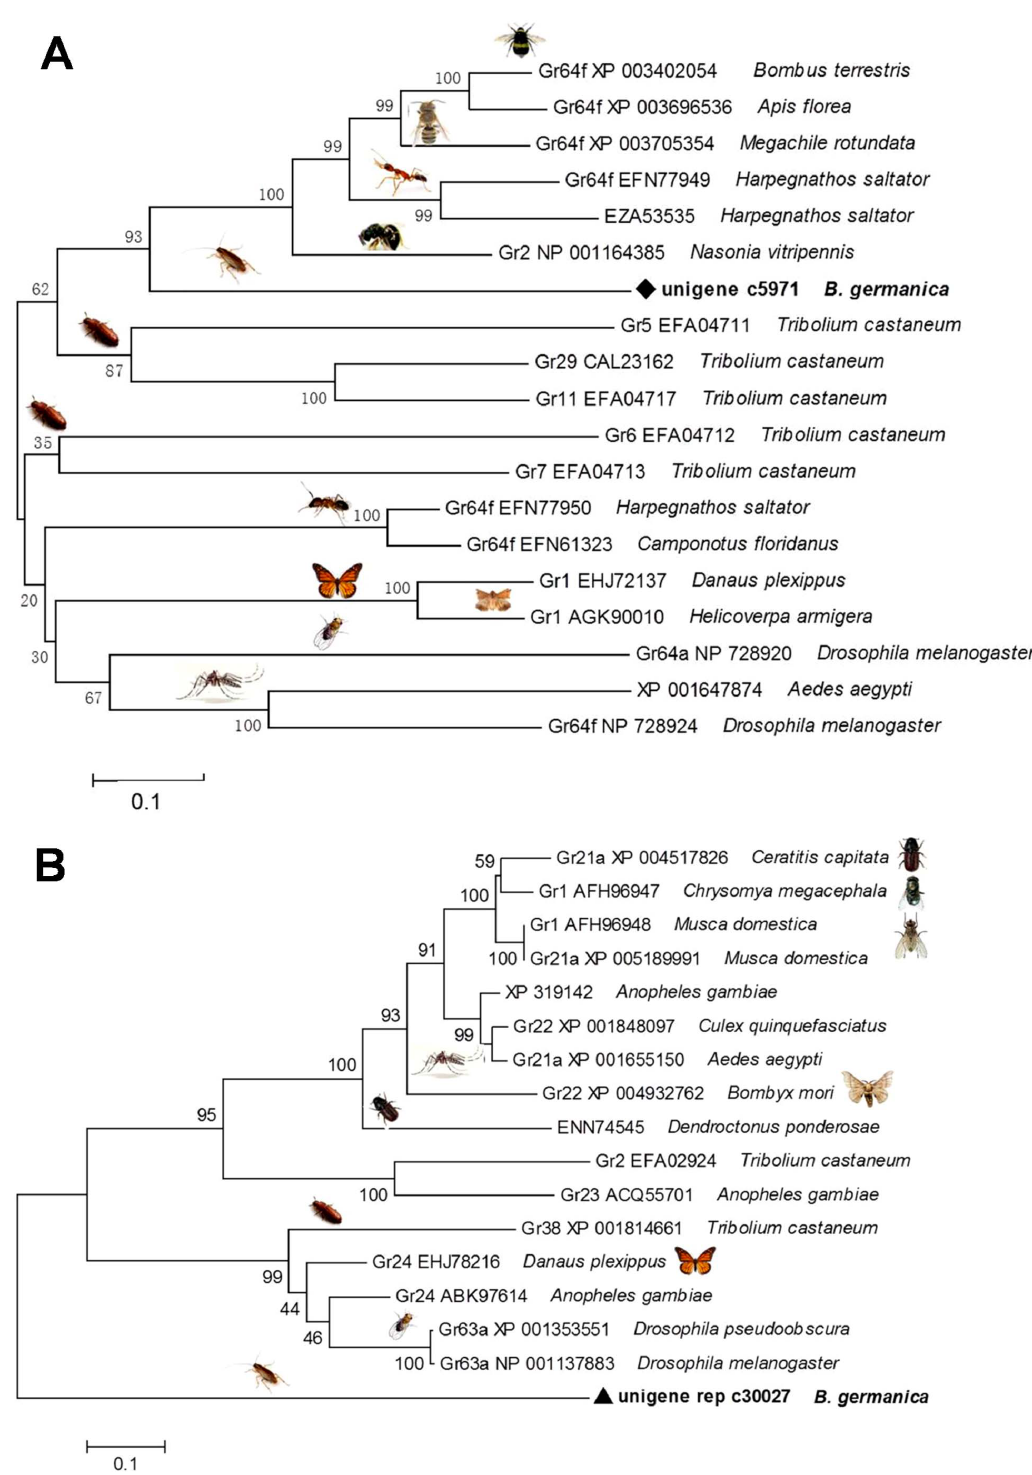
Figure 6. Phylogeny of two gustatory receptor genes from the German cockroach. Unigenes c5791 (A) and c rep c30027 (B) are highlighted in bolds and triangles ( m ). doi:10.1371/journal.pone.0106932.g006 method suggests that the 7 identified German cockroach OBPs were clustered into a group comprising related proteins of the other two cockroach species ( P. Americana and Rhyparobia